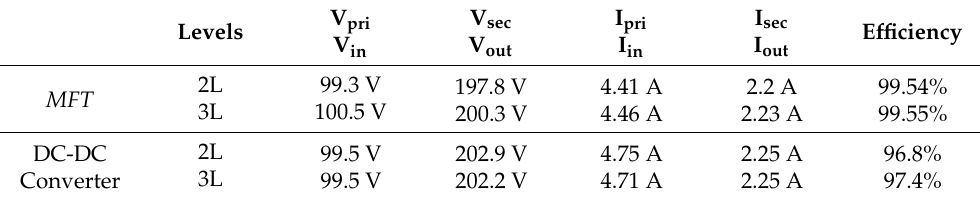
Figure 5. Topology: ( a ) MFT efficiency test and ( b ) FBDC .